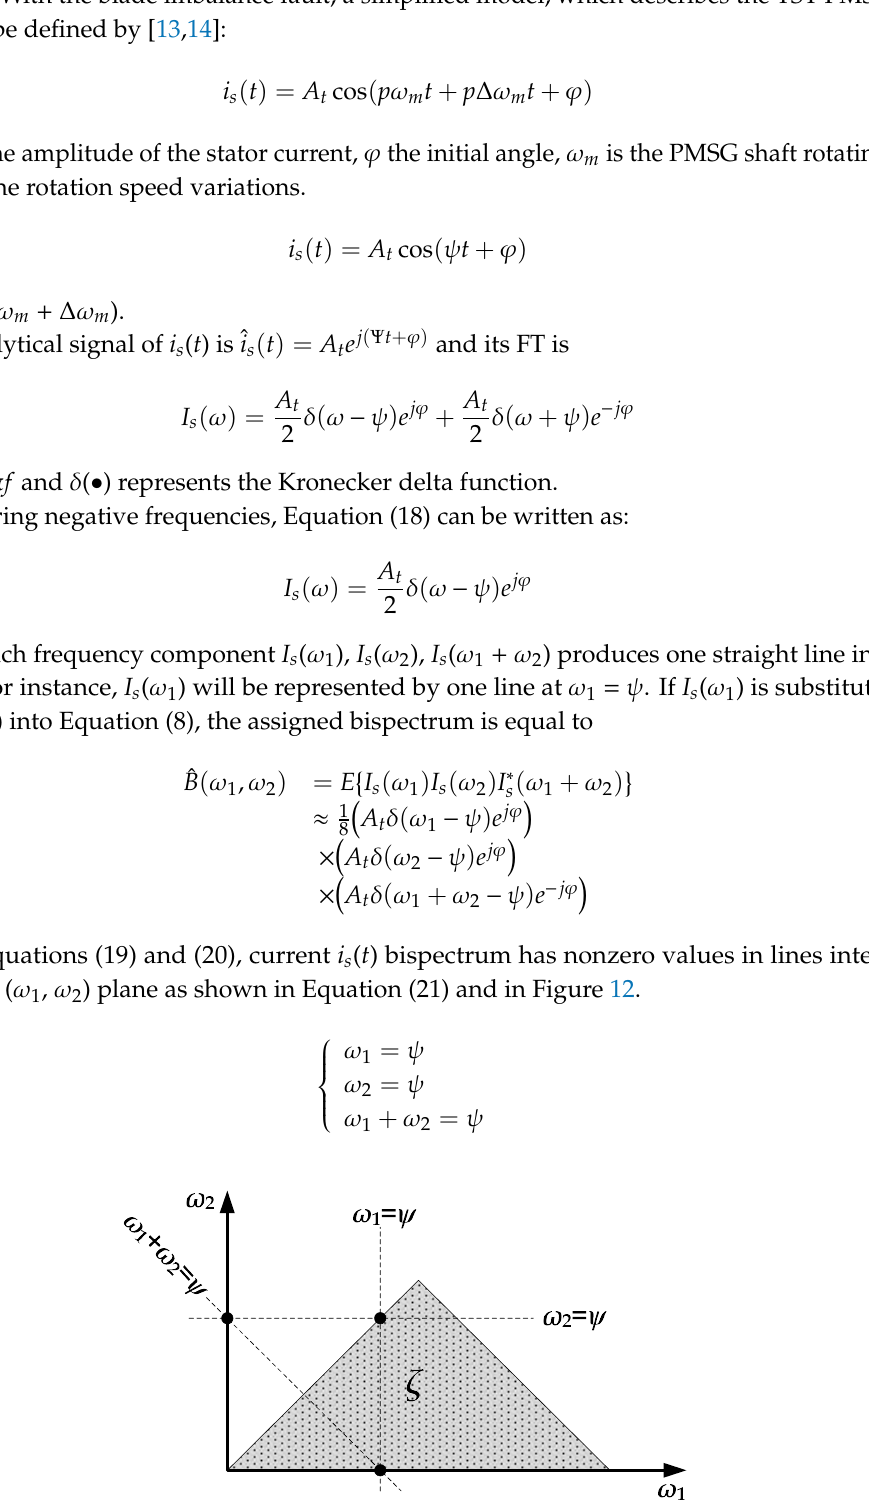
Figure 12. Theoretical bispectrum of TST PMSG stator current signal given in Equations (20) and (21).